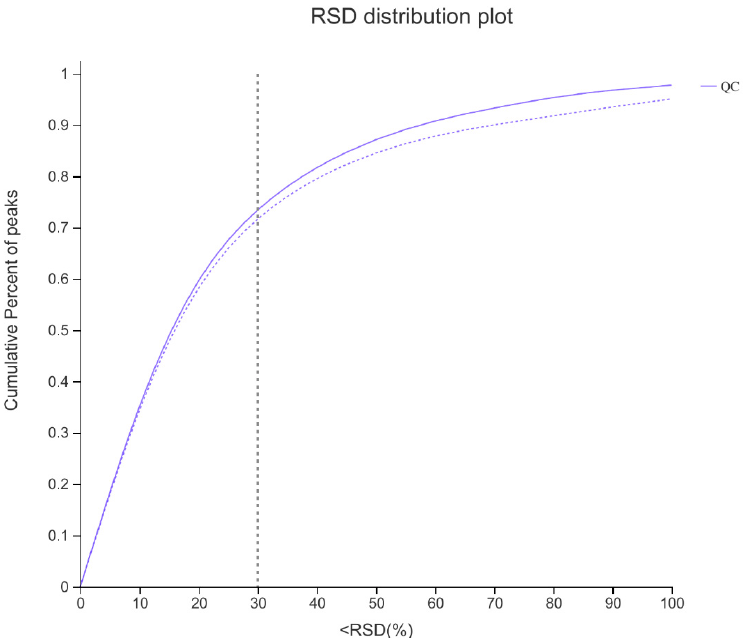
Figure 2. KEGG classification results of compounds. The ordinate is the classification of KEGG com- pounds, and the abscissa is the number of compounds annotated to this category. The bar’s color indicates that the compound belongs to the primary classification category.